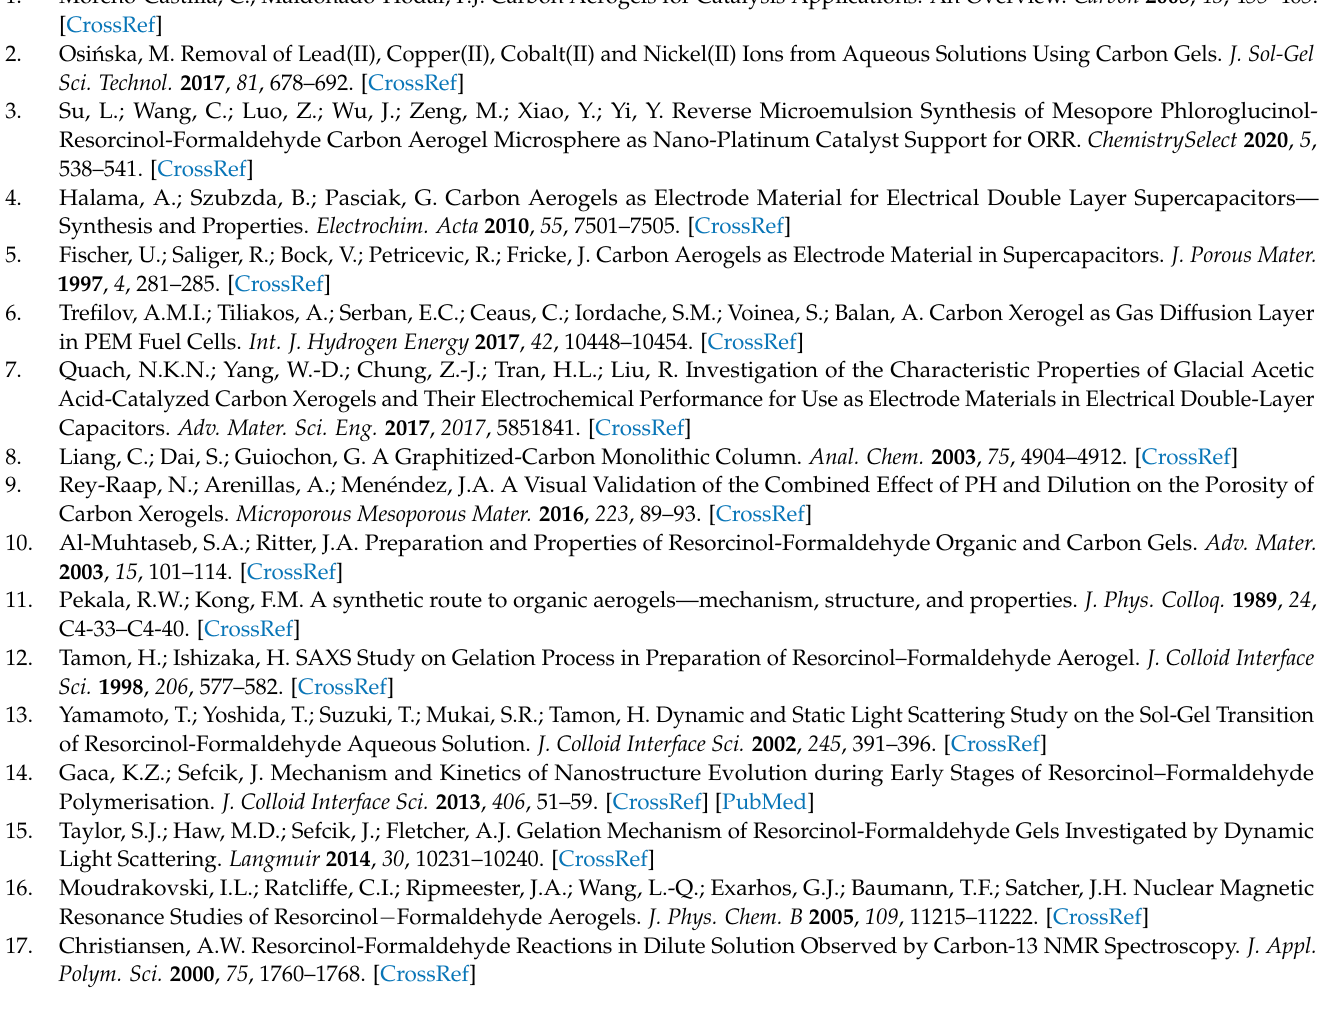
reaction. Figure S2: Temperature program of DSC measurements. Points A and B indicate the start of recording, melting, and freezing curves, respectively. Point A is considered the start of the reaction (time t =